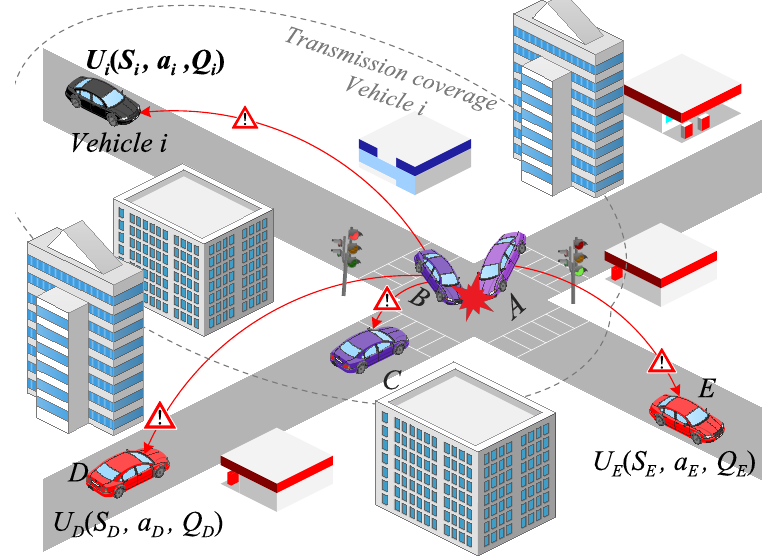
Figure 2. Forwarding Game in an urban